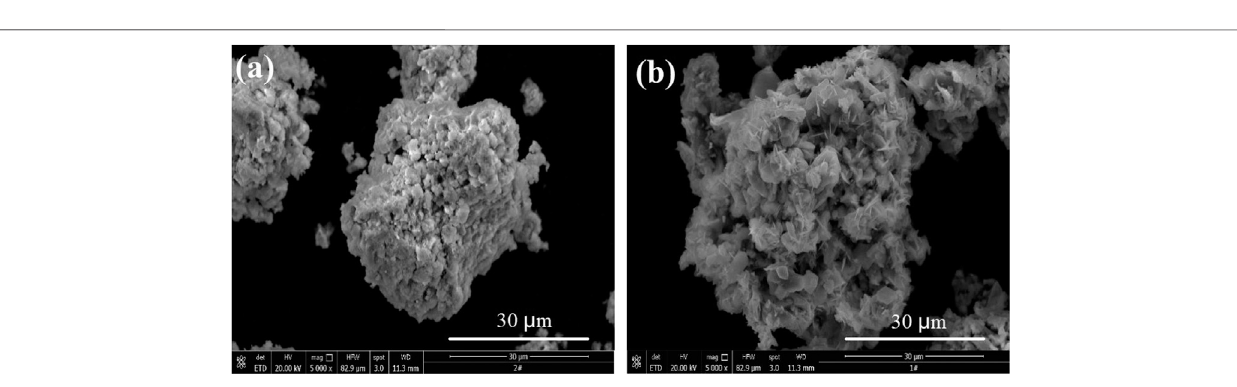
Figure 13A to plotting the natural logarithm of the apparent rate constant (ln k ) vs. the natural logarithm of the H 2 SO 4 concentration (ln [H 2 SO 4 ] ), the results can be as presented in Figure 13B .